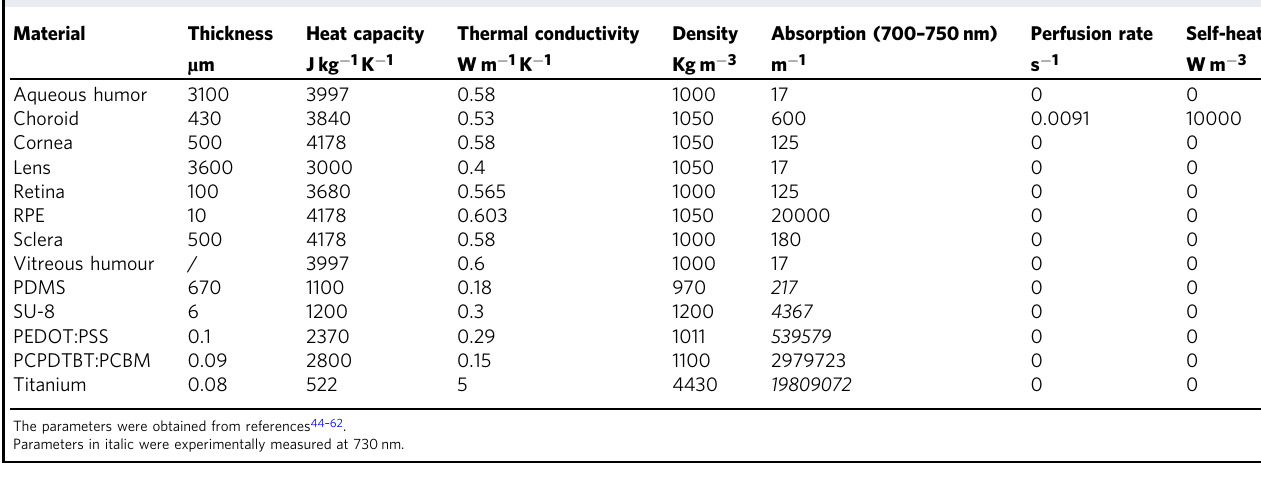
Table 1 Eye parameters for the FEM